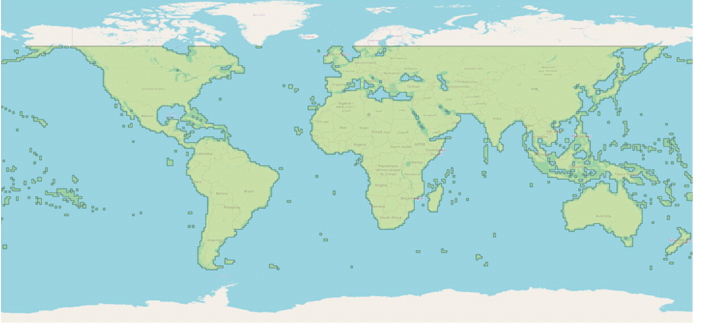
Figure 3. The spatial coverage of tiles available for download in SRTM. Source: USGS—EarthExplorer [54]. European Digital Elevation Model EU-DEM v1.0 is a digital elevation model of Eu- ropean Environmental Agency (EEA) countries (EEA member countries—Austria, Bel- gium, Bulgaria, Croatia, Cyprus, Czechia, Denmark, Estonia, Finland, France, Germany, Greece, Hungary, Iceland, Ireland, Italy, Latvia, Liechtenstein, Lithuania, Luxembourg, Malta, Netherlands, Norway, Poland, Portugal, Romania, Slovakia, Slovenia, Spain, Swe- den, Switzerland, Turkey, and United Kingdom; cooperating countries—Albania, Bosnia and Herzegovina, Kosovo, Montenegro, North Macedonia, and Serbia). The EU-DEM is a hybrid product based on Shuttle Radar Topography Mission (SRTM) and Advanced Spaceborne Thermal Emission and Reflection Radiometer (ASTER) Global Digital Eleva- tion Model (GDEM); data were fused by a weighted averaging approach. The EU-DEM v1.1 is a resulting dataset of the EU-DEM v1.0 upgrade. A number of properties were upgraded, for example, geo-positioning and vertical accuracy. EU-DEM v1.1 upgrade was coordinated through the Copernicus program [48]. EU-DEM v1.1 is available in GeoTIFF format; the dataset is divided into 1000 × 1000 km tiles, at 25 m resolution with vertical accuracy: +/ − 7 m. The spatial coverage of tiles available for download is shown in Figure 4.